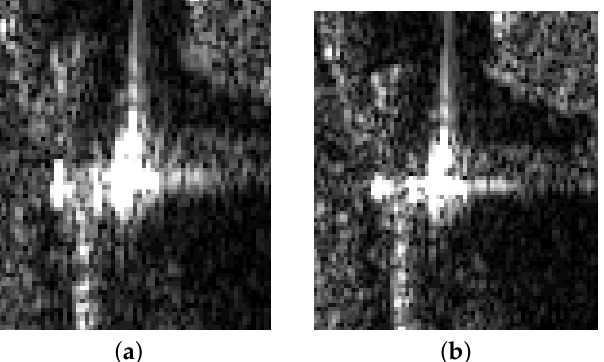
Figure 13. The comparison of 2D results of point targets. ( a ) The comparison method; ( b ) the proposed method.